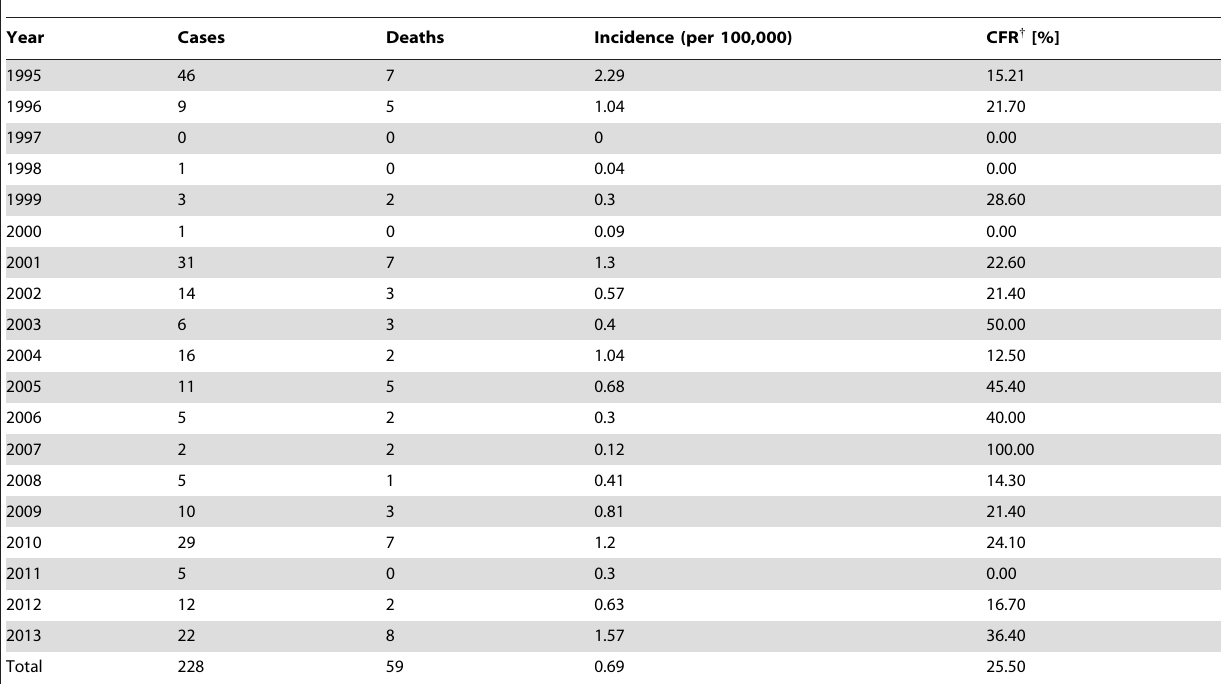
Table 1. CCHF case statistics from 1995 to August